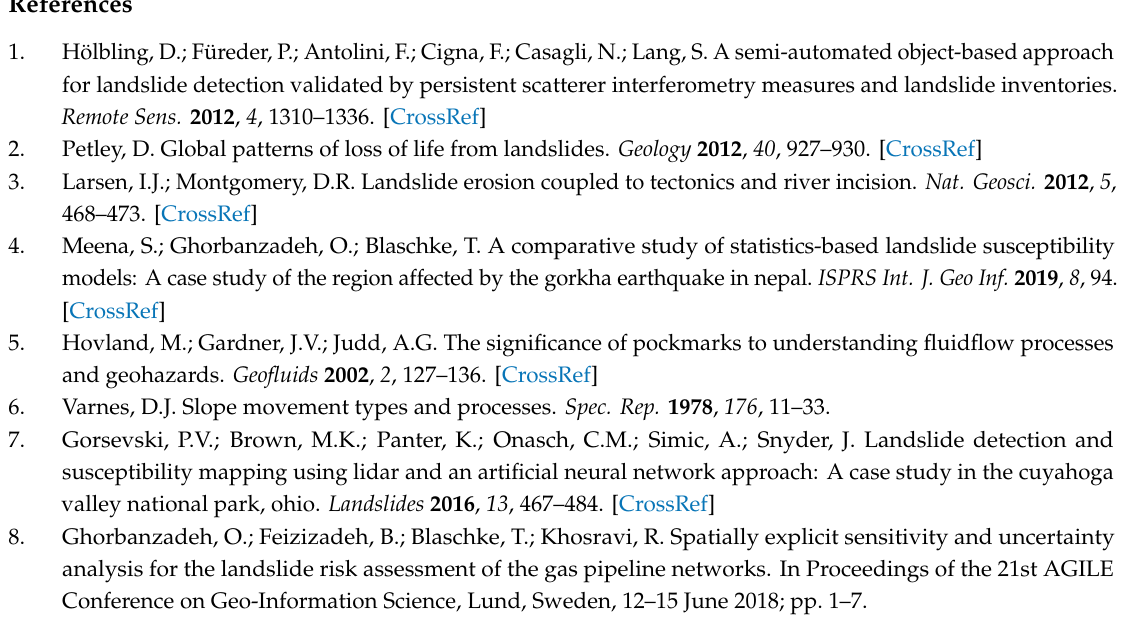
Table S1: The normalized weights for the classes of the criteria based on the frequency ratio (FR) technique for each digital evaluation model (DEM); Table S2: Resulting R-indexes for the landslide susceptibility mapping (LSMs) based on the three di ff erent resolution DEMs for training data; Table S3: Resulting R-indexes for the LSMs based on the three di ff erent resolution DEMs for testing